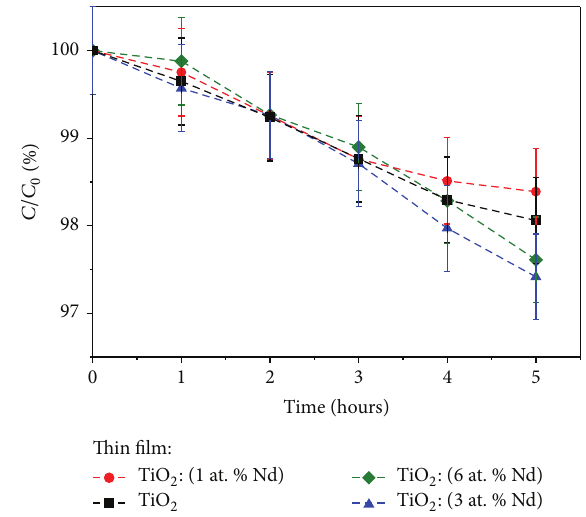
Figure 10: Photocatalytic activity of TiO 2 and TiO 2 :Nd (1, 3, and 6 at. % of neodymium) thin films after exposure to the UV-Vis light. Designations: 𝐶 0 : initial concentration and 𝐶 : concentration of methyl orange after time 𝑡